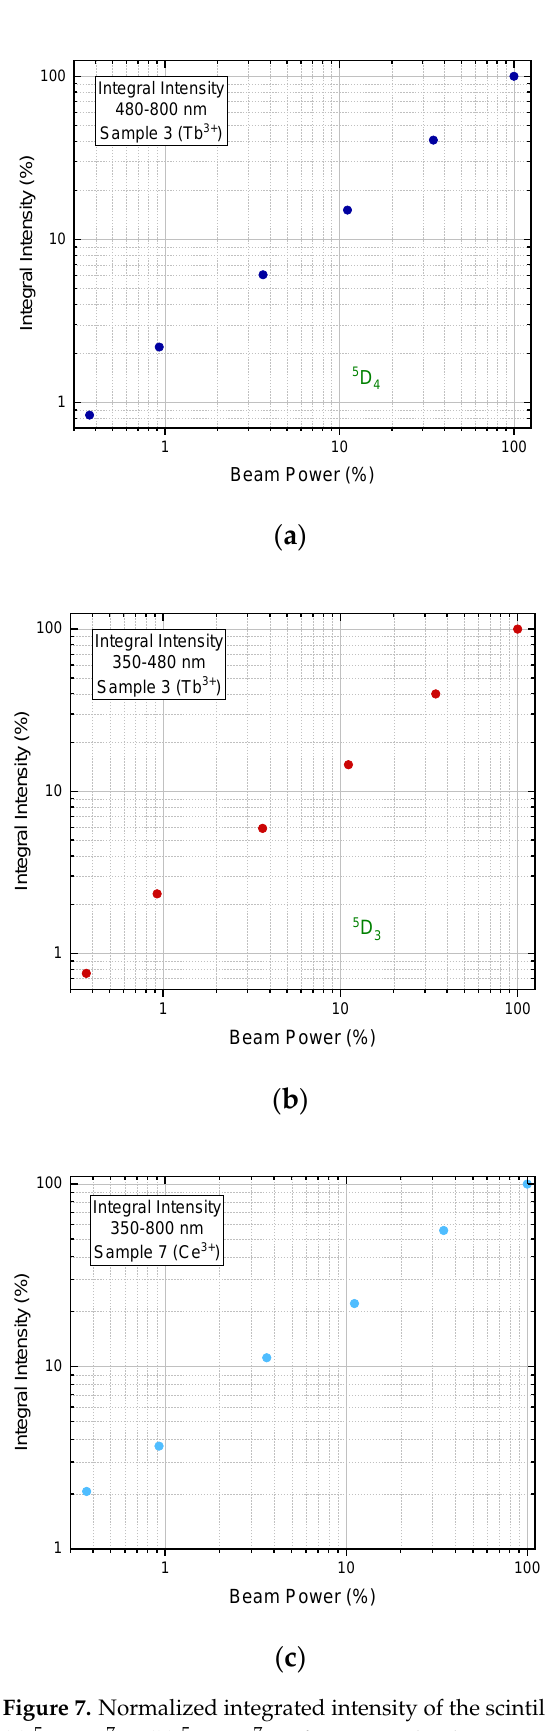
Figure 7. Normalized integrated intensity of the scintillation in the spectral range of the transitions: ( a ) 5 D 4 → 7 F J ; ( b ) 5 D 3 → 7 F J of GYAGG:Tb, Tb = 0.15 ; ( c ) GYAGG:Се.